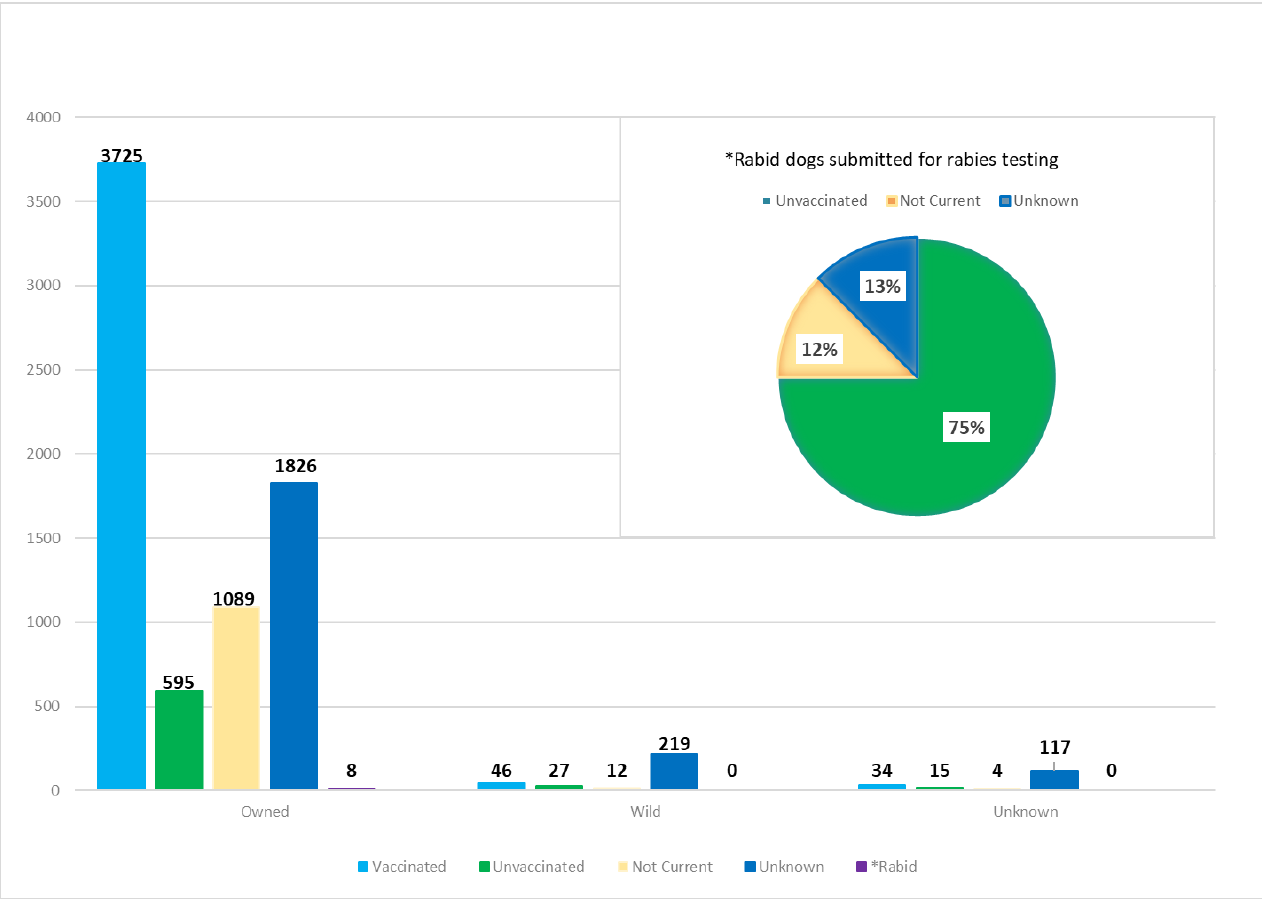
Figure 5. Ownership and vaccination status of dogs submitted to the NYSDOH Rabies Laboratory. Inset shows details of the eight dogs that were positive over the same 2008–2020 timeframe.